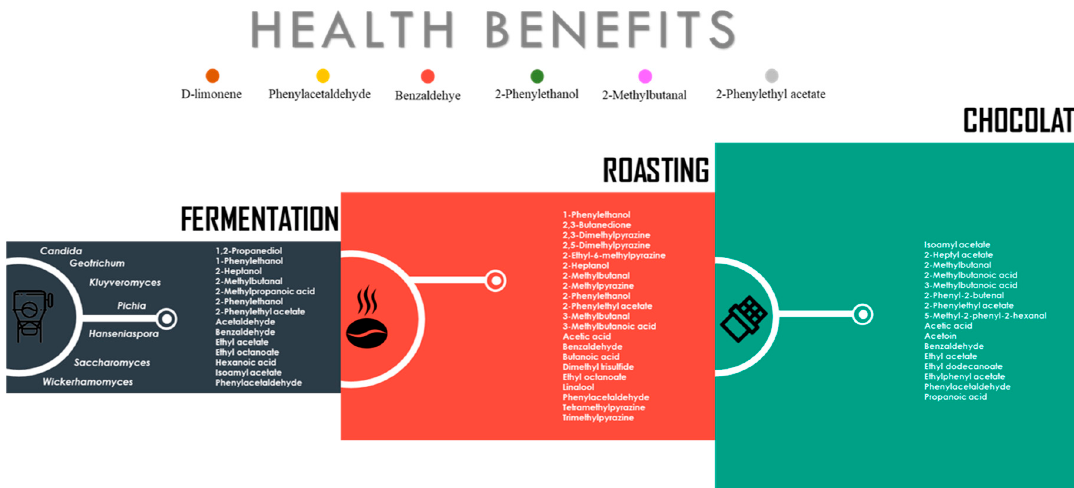
Figure 1. Tracking volatile compounds from chocolate.